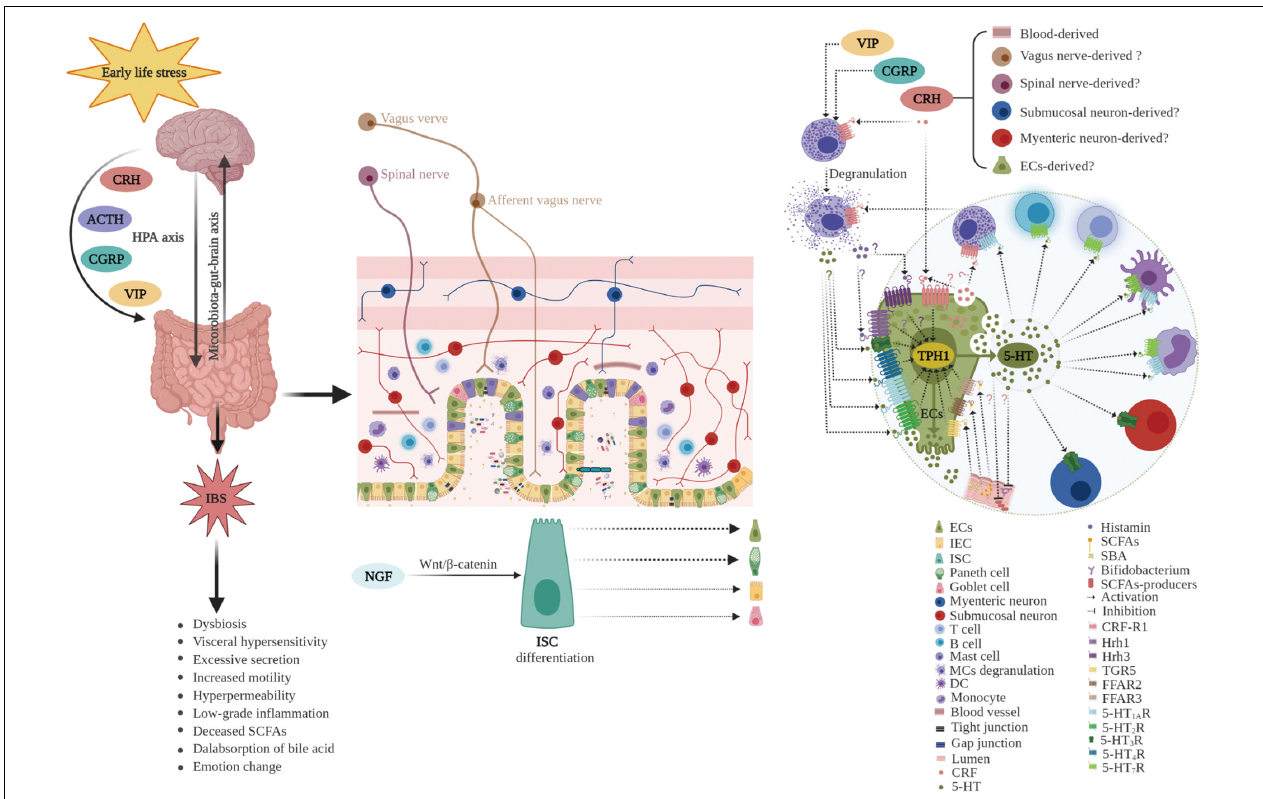
FIGURE 5 | Potential role of enterochromaffin cells in early life stress-induced irritable bowel syndrome. ELS chronically activates the HPA axis and increases the levels of neuropeptides, such as CRH, CGRP, VIP, and ACTH. Furthermore, ELS disrupts intestinal homeostasis and the microbiota–gut–brain axis through various pathways including neuroendocrine and immune activation (such as degranulation of mast cells), differentiation of ISC toward secretory lineages including ECs, alterations in the composition of intestinal microbiota (decreased abundance of SCFAs producers, such as Bifidobacterium ), and thus, changes in metabolites (including reduced SCFAs and increased SBA). Moreover, hyperplasia of ECs and upregulation of TPH1 result in excessive 5-HT release. 5-HT acts on various 5-HT receptors in neighboring cells and nerves, inducing visceral hypersensitivity, excessive secretion, increased motility, hyperpermeability, and the genesis of anxiety or depression. ECs play a vital role in the pathogenesis of ELS-induced IBS. ECs, enterochromaffin cells; ELS, early life stress; HPA, hypothalamic–pituitary–adrenal; CRH, corticotropin releasing hormone; CGRP, calcitonin gene-related peptide; VIP, vasoactive intestinal peptide; ACTH, adrenocorticotropic hormone; ISC,